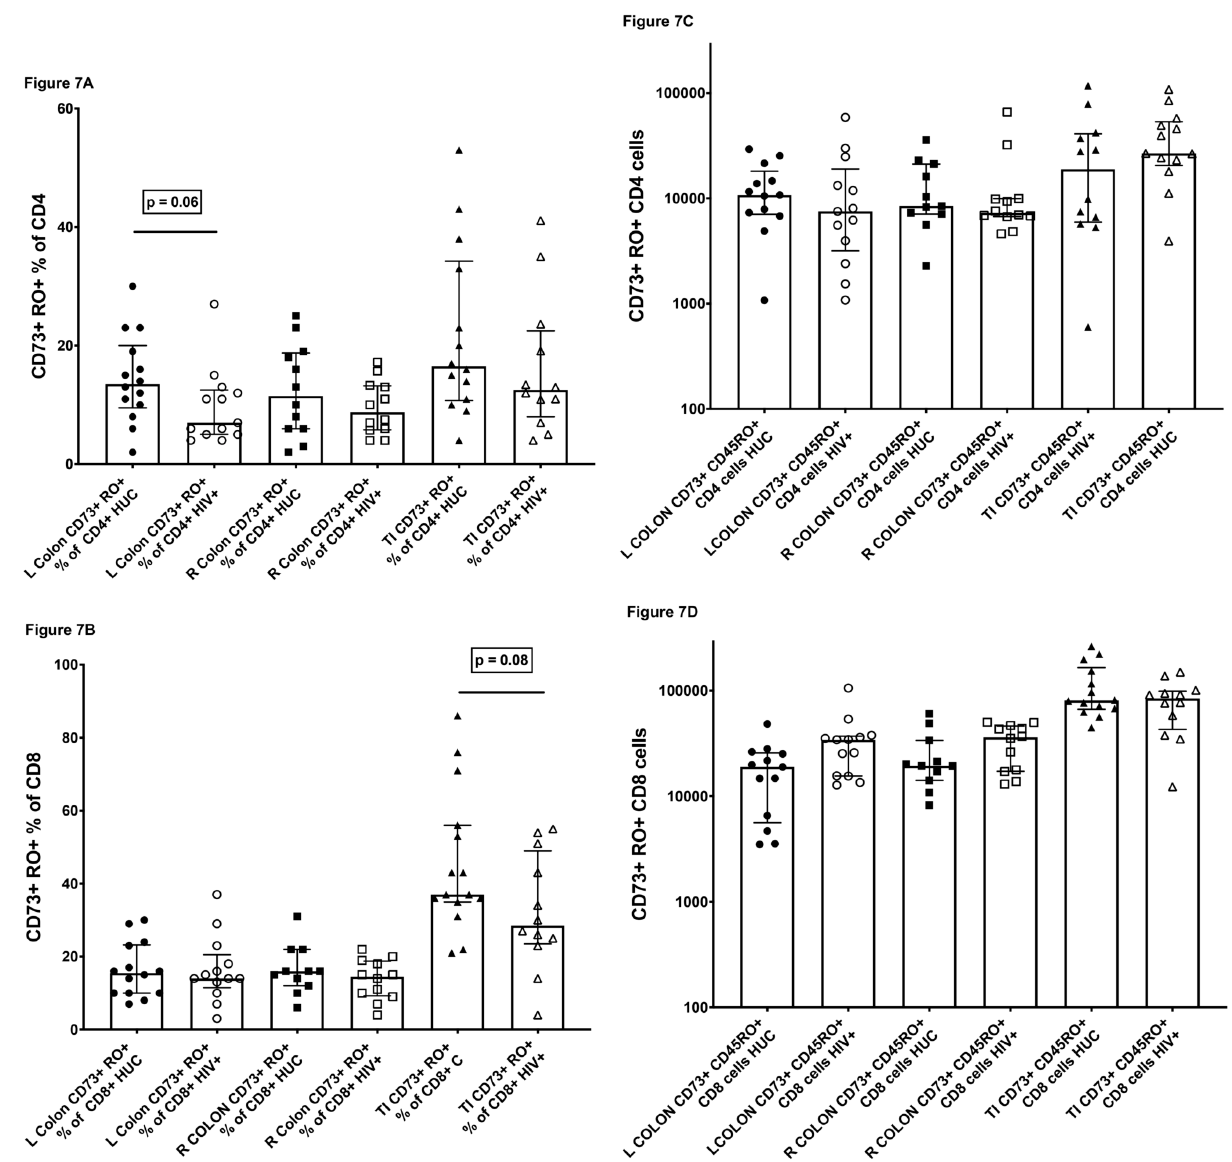
Figure 7. CD73+ CD45RO+ memory CD4+ T cells in gut biopsies. ( A ) CD73+ CD45RO+ memory cells as a percentage of CD4+ T cells in single cell suspensions prepared from left colon (LC), right colon (RC) or terminal ileum (TI), from subjects that were HIV-uninfected controls (HUC), versus HIV+ subjects on ART (HIV+). ( B ) CD73+ CD45RO+ memory cells as percentage of CD8+ T cells in single cell suspensions prepared from left colon (LC), right colon (RC) or terminal ileum (TI), from subjects that were HIV-uninfected controls (HUC), versus HIV+ subjects on ART (HIV+). ( C ) Absolute cell counts of CD73+ CD45RO+ memory CD4+ T cells in single cell suspensions prepared from left colon (LC), right colon (RC) or terminal ileum (TI), from subjects that were HIV-uninfected controls (HUC), versus HIV+ subjects on ART (HIV+). ( D ) Absolute cell counts of CD73+ CD45RO+ memory CD8+ T cells in single cell suspensions prepared from left colon (LC), right colon (RC) or terminal ileum (TI), from subjects that were HIV-uninfected controls (HUC), versus HIV+ subjects on ART